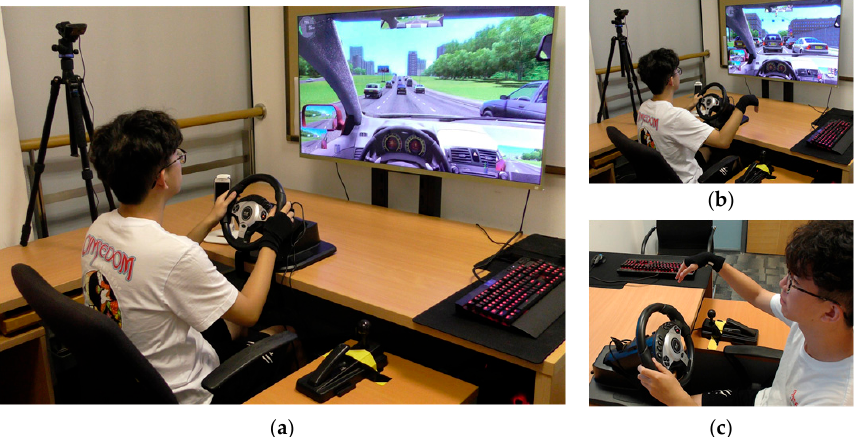
Figure 2. ( a ) A participant driving the simulator while wearing the wrist-band on a three-lane highway. Smartphone is mounted on the participant’s preferred location. ( b ) and ( c ) Two different angles of video capturing of the participant while performing gestures and driving the car.